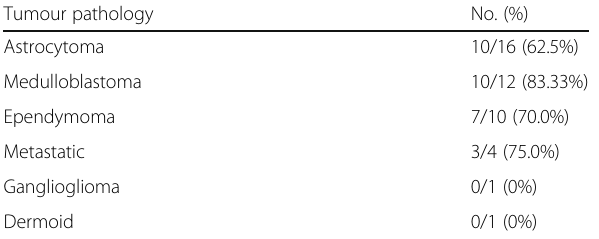
Table 2 The incidence of shunt insertion